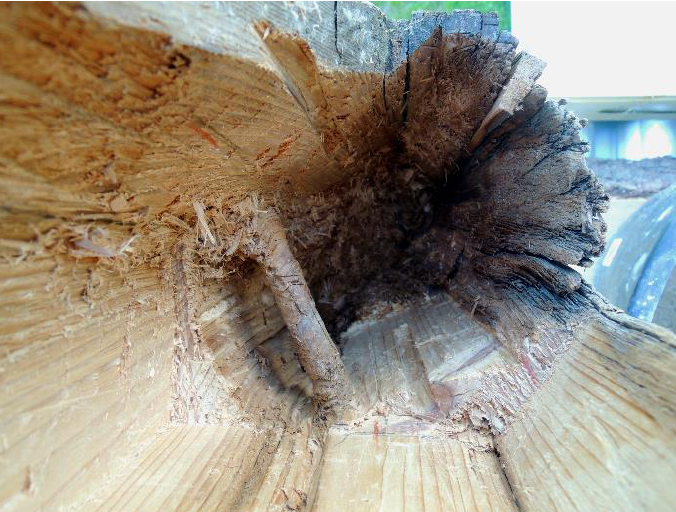
Figure 16. Detail of the cleaned hole in the central part of the beam, including the grooves for the rear insert.